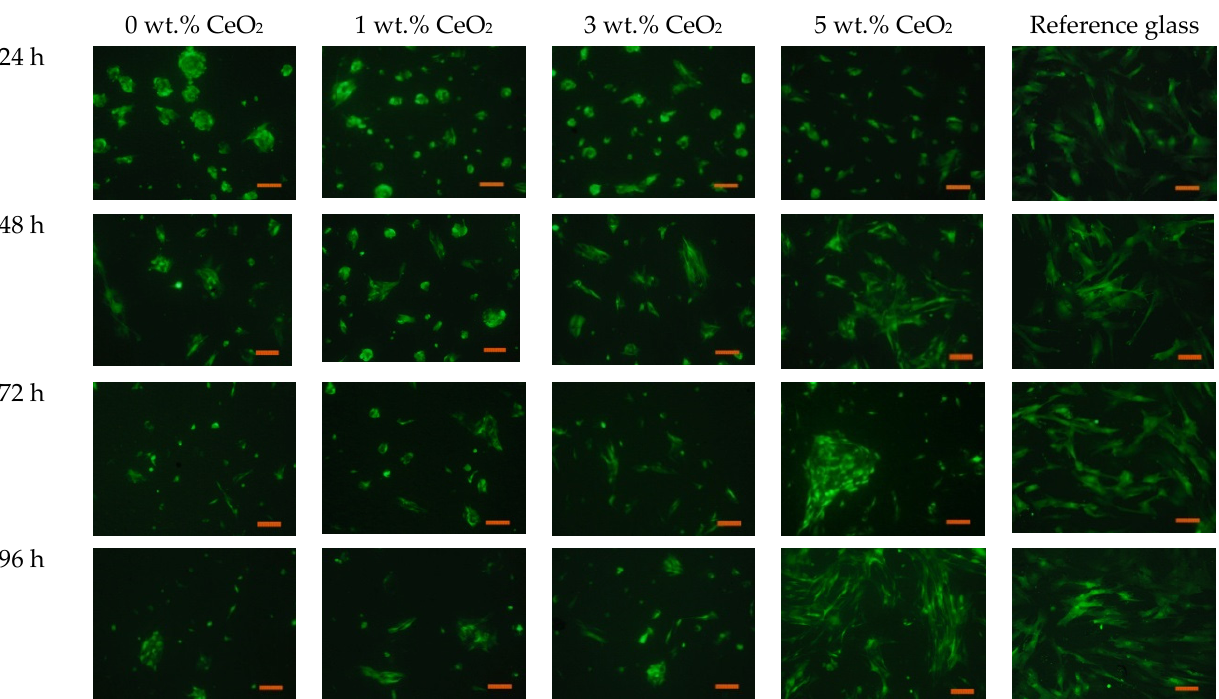
Figure 6. Fluorescence microscopy images of mouse MSC with GFP gene on the surface of the